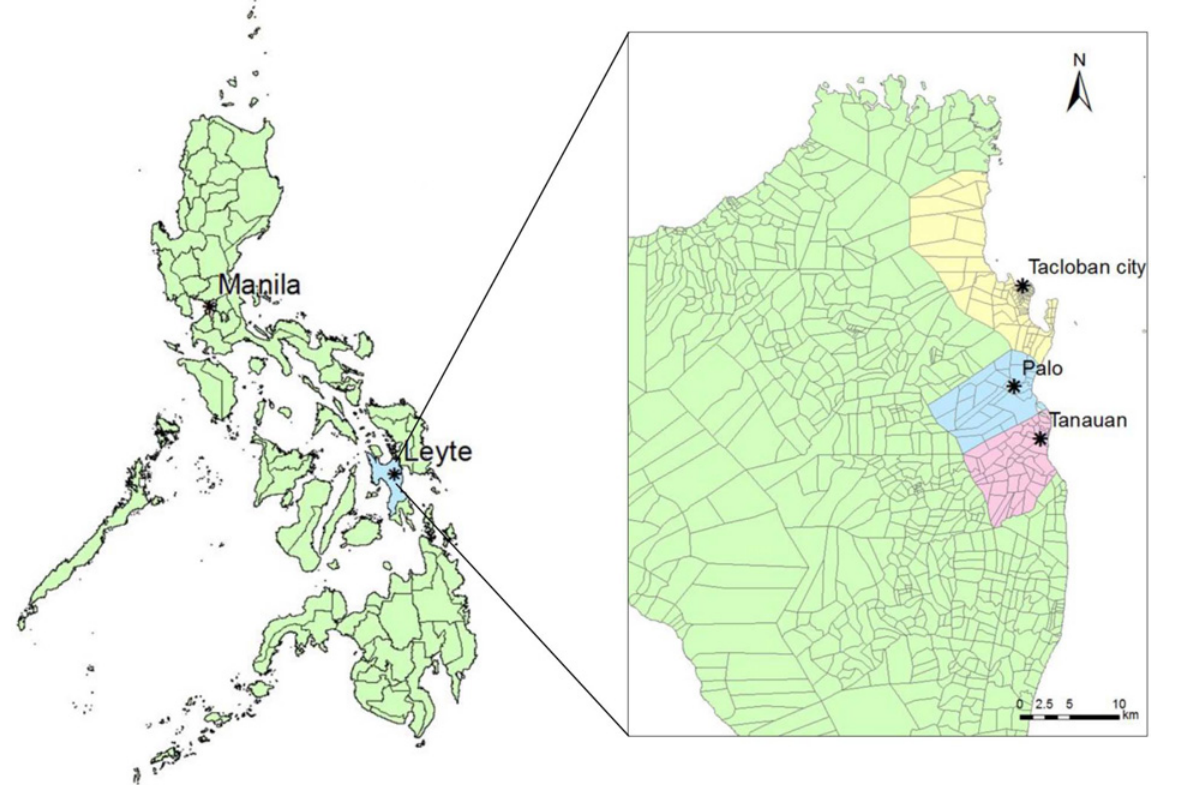
Fig 1. Locations of the 3 sentinel sites in the Eastern Visayas region, the Philippines. Map source; DIVA-GIS website (http://www.diva-gis.org/gdata).